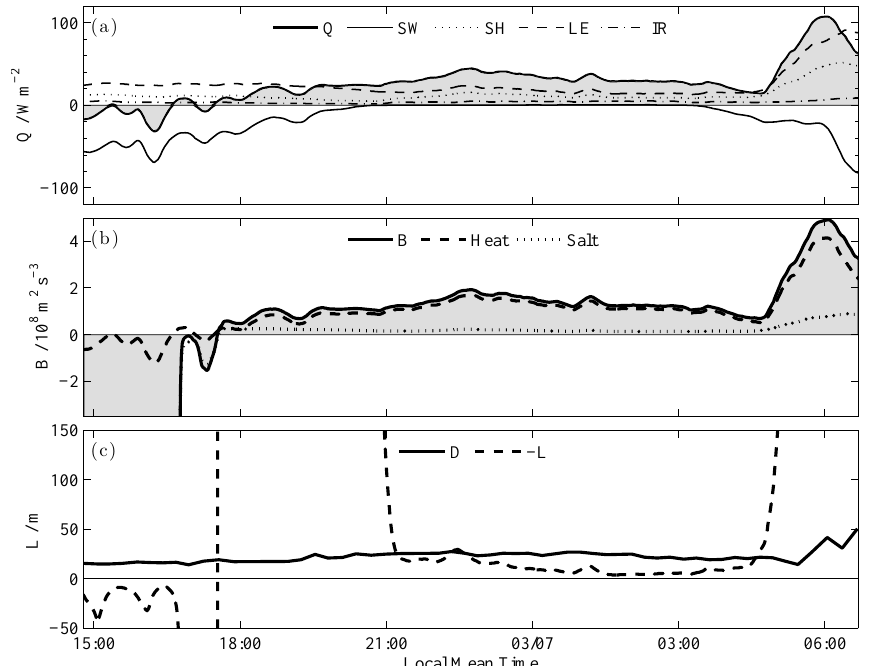
Fig. 7. (a) Net radiative flux ( Q ), short wave (SW), sensible heat (SH), latent heat (LE), and net infrared (IR) radiation during the deployment. Positive is upwards out of the ocean. The net surface buoyancy flux ( B ) and the relative contributions from heat and salt and shown in (b) . (c) shows the mixed layer depth ( D ) and the Monin–Obukhov length ( L